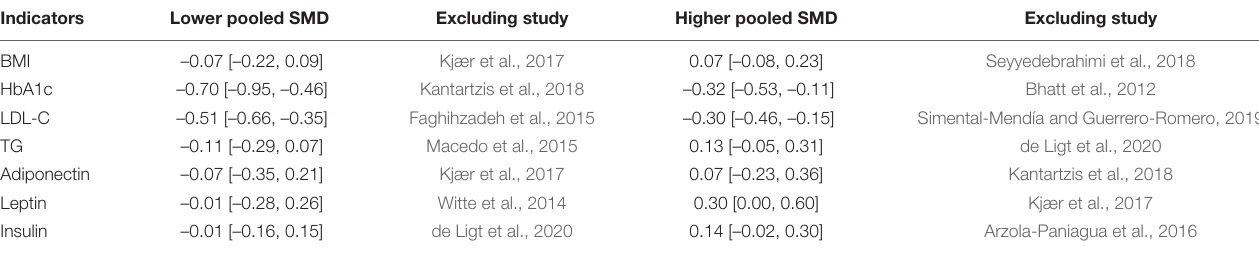
TABLE 3 | Other indicators in the sensitivity